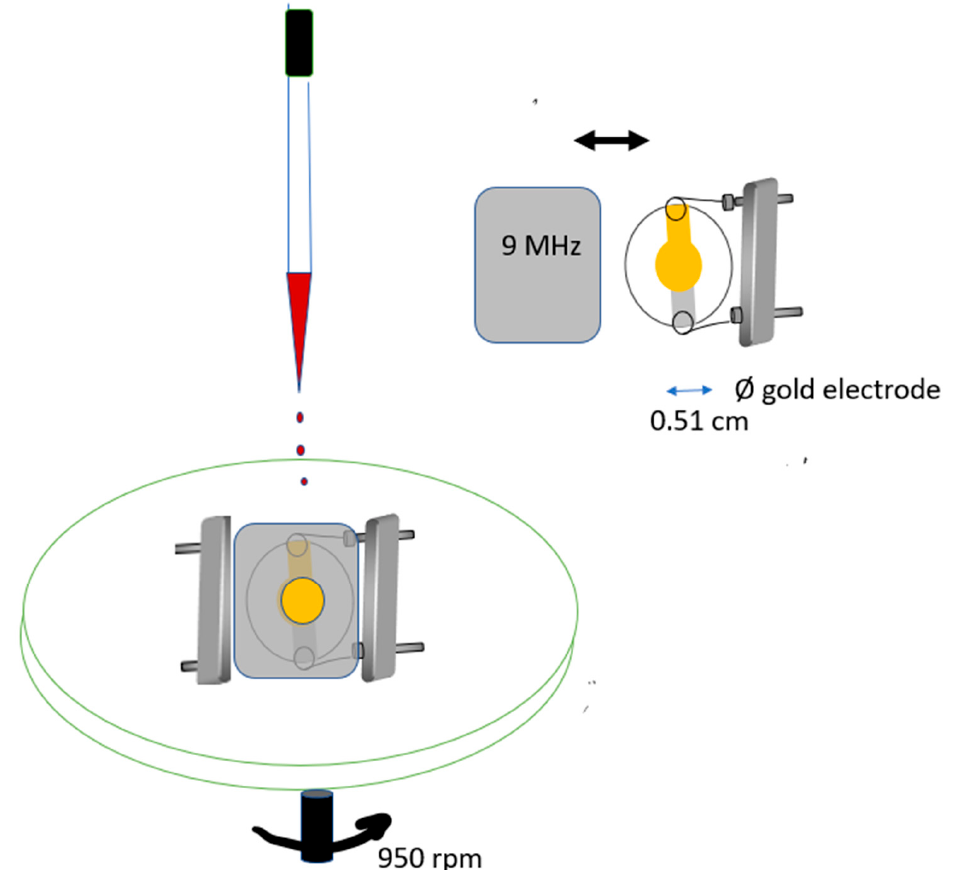
Figure 2. Picture of the bare quart crystal, out of its metal lid, and scheme used for coating application: small drops of the porphyrin solution were applied over the crystal electrode, through a hole cut at the centre of the lid, and spread by spinning.